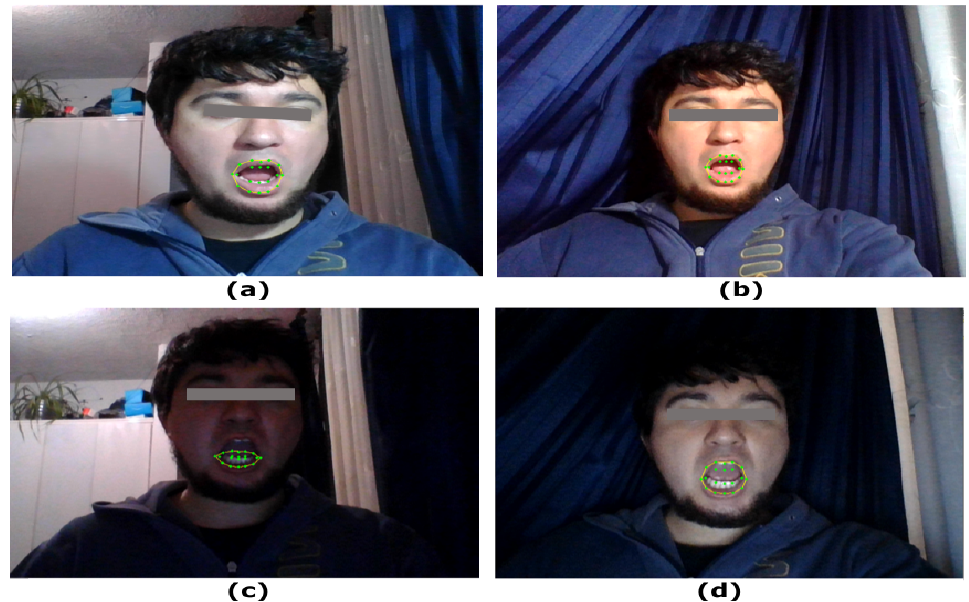
Figure 9. Face detection and mouth landmark prediction at different lighting levels. ( a ) Image captured at 59 lux. ( b ) Image captured at 32 lux. ( c ) Image captured at 24 lux. ( d ) Image captured at 2 lux.